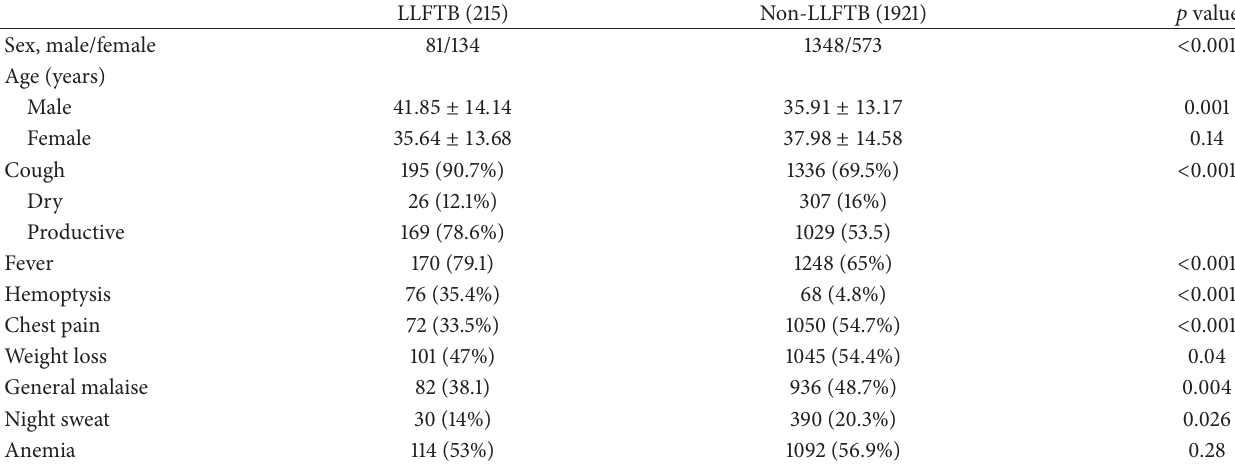
Table 1: Clinical characteristic in lower lung field tuberculosis (LLFTB) and non-LLFTB